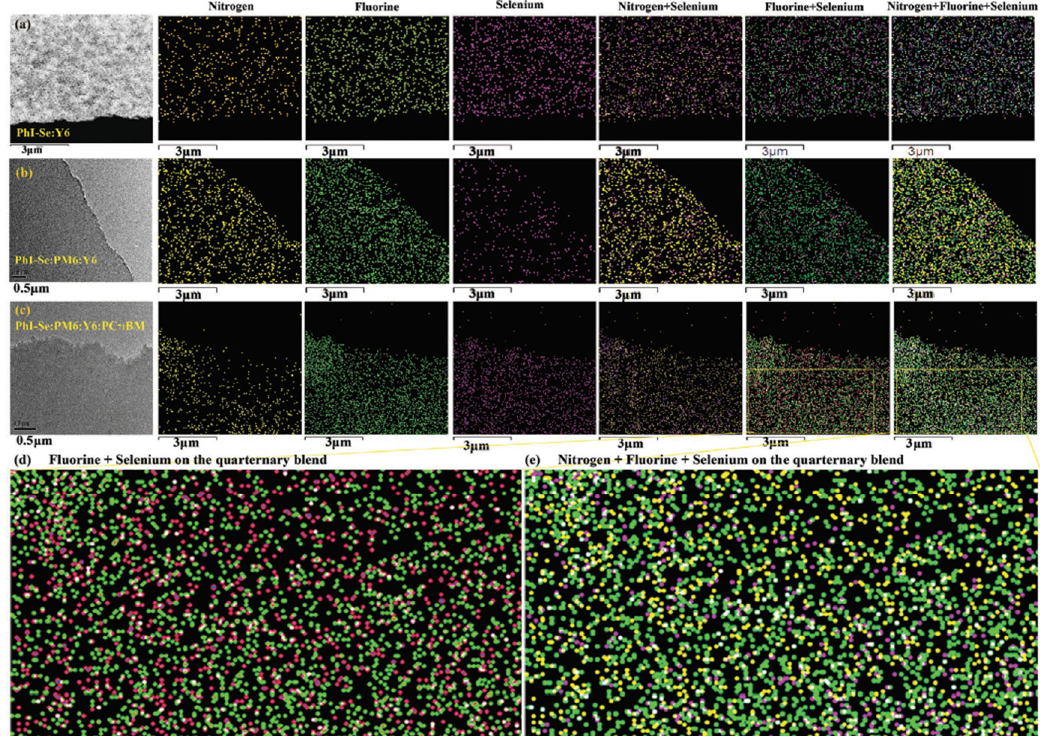
Figure 12. ( a – c ) Distribution of N, F and Se; ( d , e ) enlarged pictures. Reproduced from [51]. Reprinted with permission from ref. [51]. Copyright 2020 Wiley.